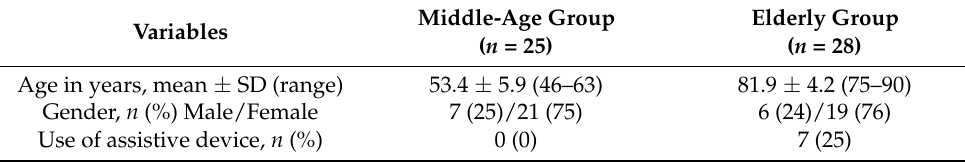
Table 1. Characteristics of the study samples ( n = 53).